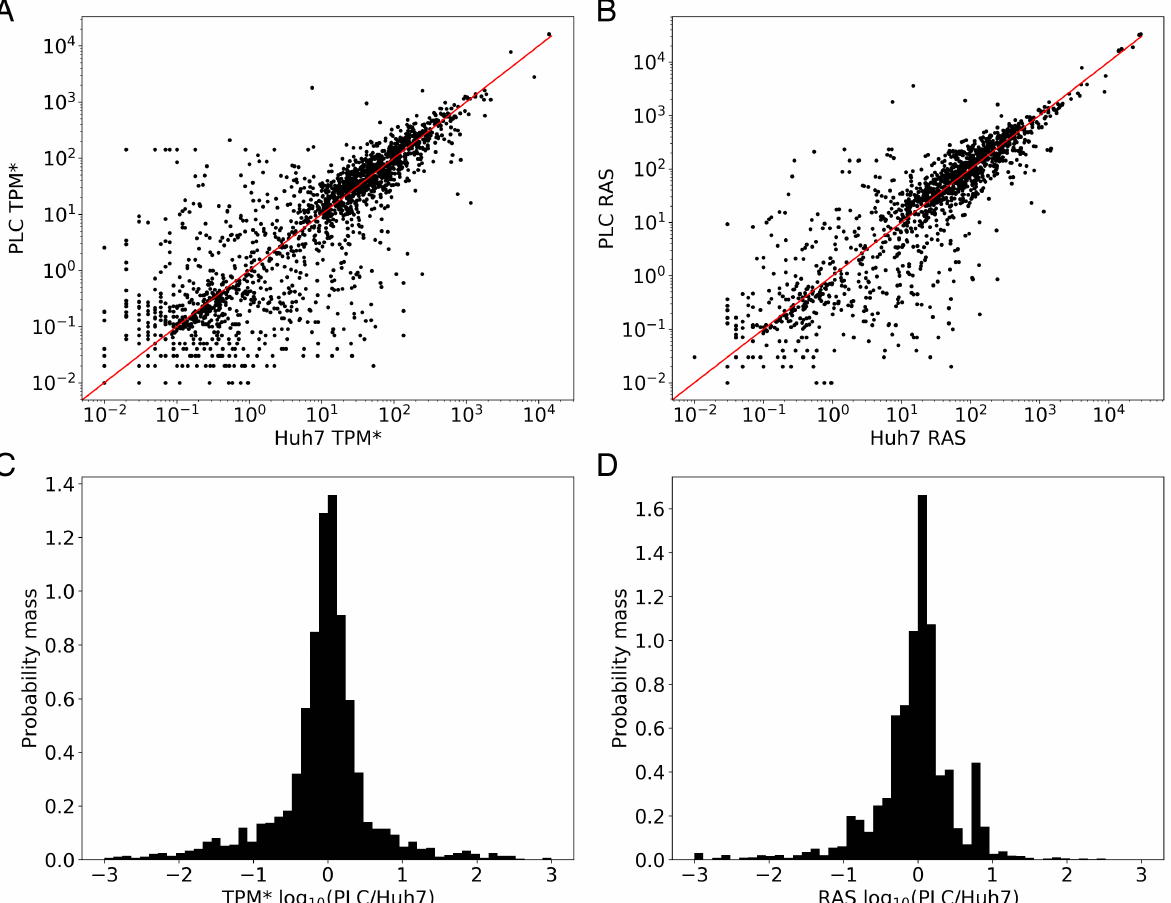
Figure 2. ( A ) Correlation of the mRNA levels (in terms of TPM* scores) between the Huh7 and PLC cell lines for all metabolic genes represented in Recon3D. The line PLC-TPM* = Huh7-TPM* represents theoretical identical scores between the cell lines. ( B ) 2D comparison of the RAS scores (dealing with multi-subunit proteins and isoenzymes) of the Huh7 and PLC cell lines for all metabolic genes represented in Recon3D. ( C ) Histogram of the probability mass function of the log10 of the ratio of the TPM* scores between the two cell lines (PLC relative to Huh7) shown in ( A ). ( D ) Histogram of the probability mass function of the log of the ratio of the RAS scores between the two cell lines (PLC relative to Huh7) shown in ( B 10